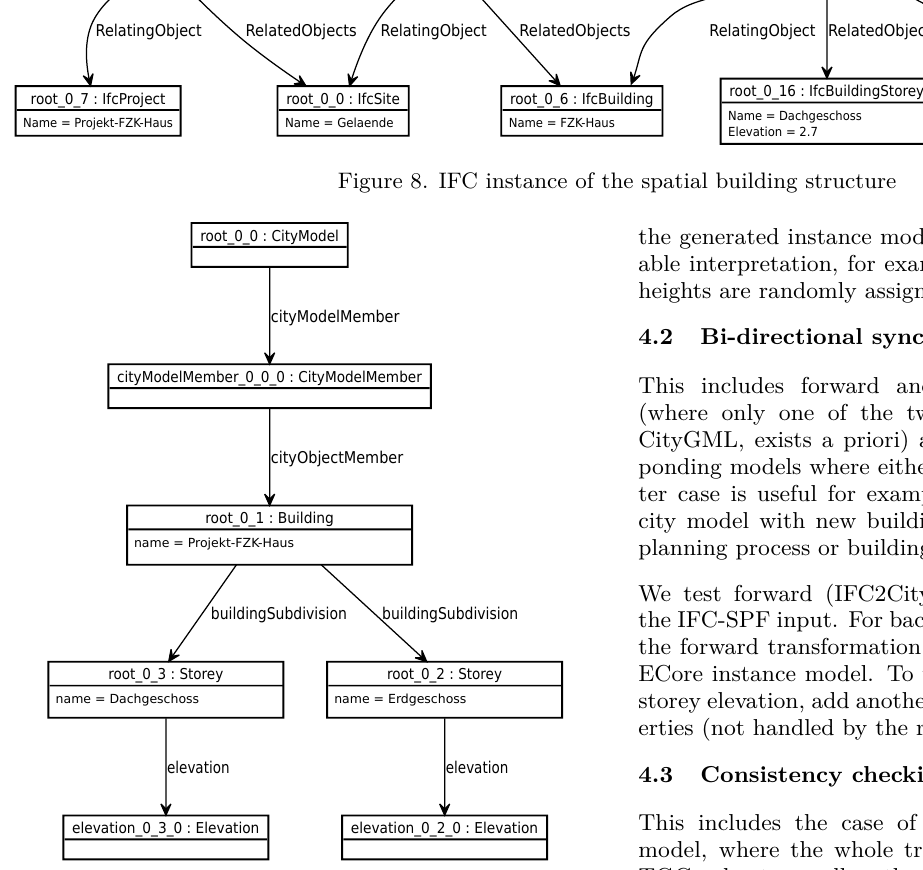
Figure 9. CityGML instance of the spatial building